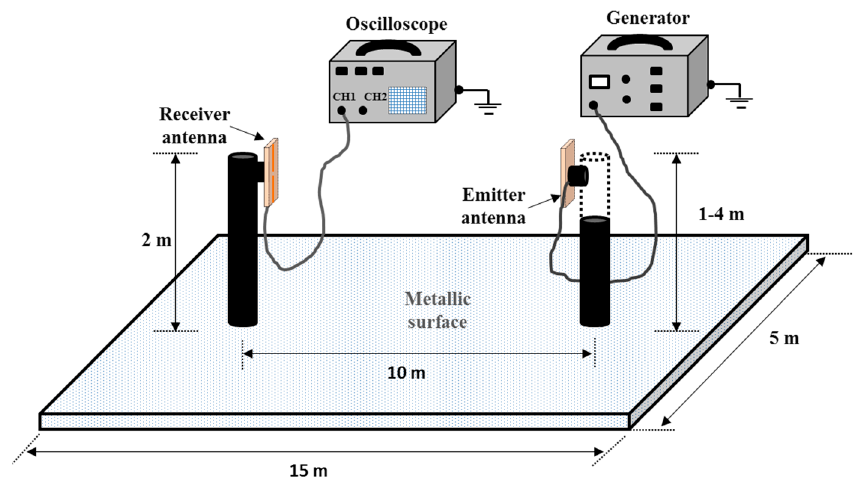
Figure 5. Schematic of the experimental set up used to estimate the antenna factors of the 0.3 m dipole antenna (or electric field probe). The transmitter antenna was a 2 m-dipole antenna. The 2 m-dipole antenna was used as a transceiver to avoid complex coupling connection to the 0.3 m-dipole antenna to be used as a transceiver. The initial measurement phase considered the 2 m-dipole antenna, in order to find the AF for that configuration. In the final measurement stage the transceiver was replaced with a 0.3 m-dipole, in order to determine the AF of that receiving antenna.